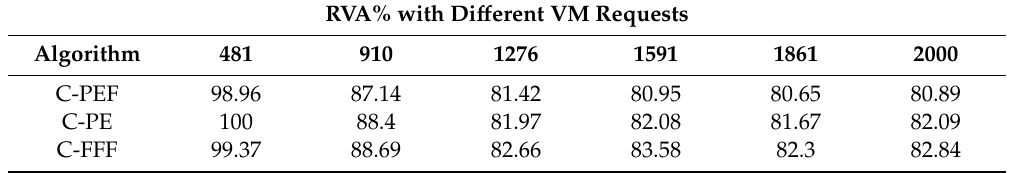
Table 11. RVA % with dynamic PUE.